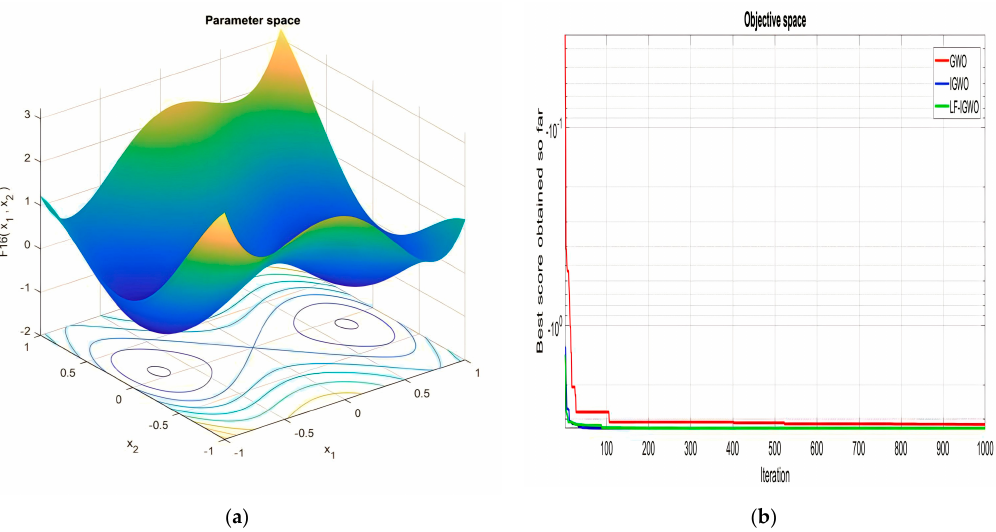
Figure 18. ( a ) Search space for fixed dimensional function F16 ( b ) Comparison of convergence curve for F16.